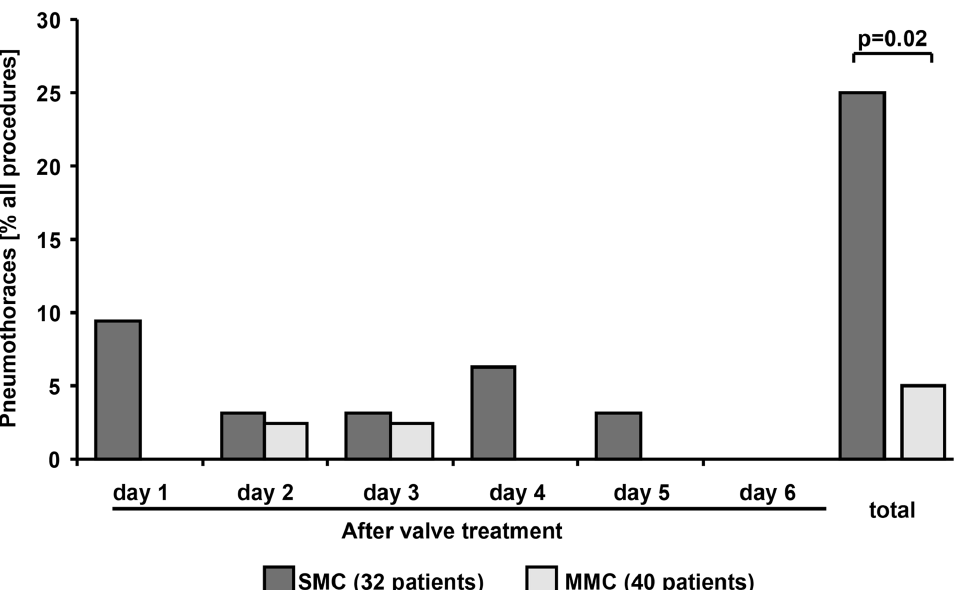
Fig 2. Incidence of pneumothorax after ELVR. Pneumothoraces occurred less often in the Modified Medical Care (MMC) than in the Standard Medical Care (SMC) cohorts.